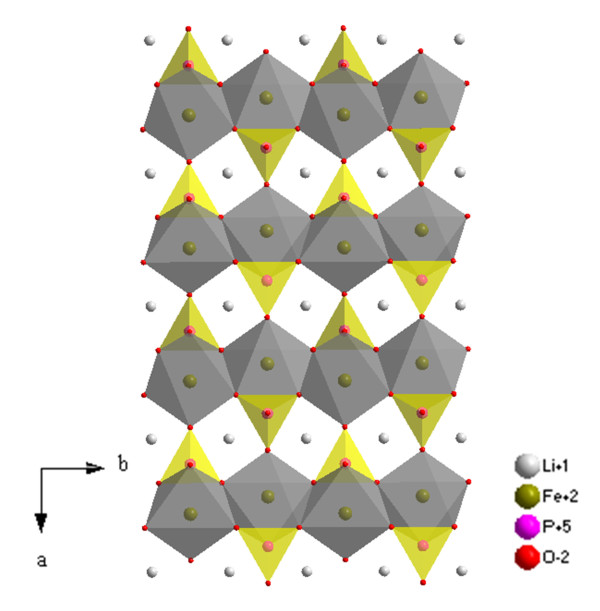
The crystal structure of olivine LiFePO4 in projection along [001].